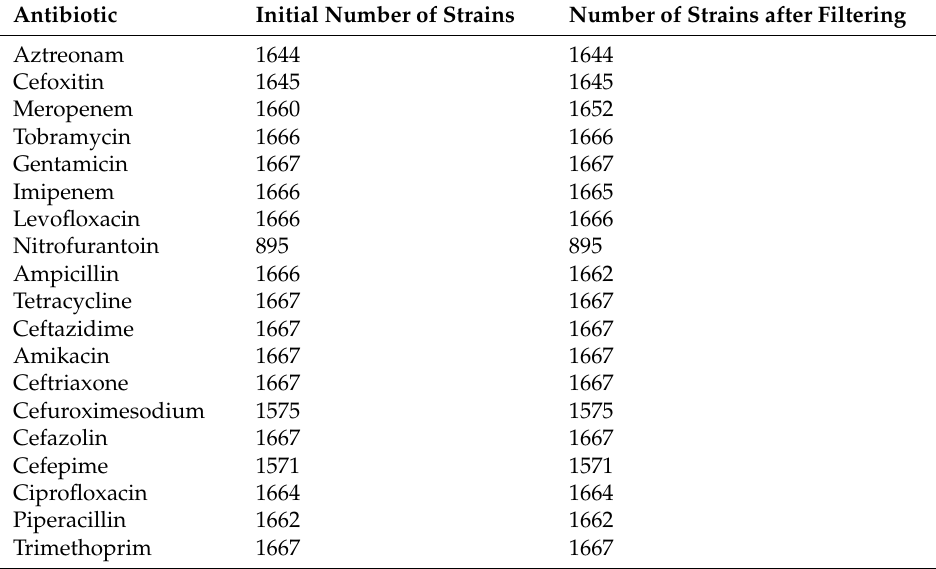
Table A3. K. pneumoniae . Number of genomes for each